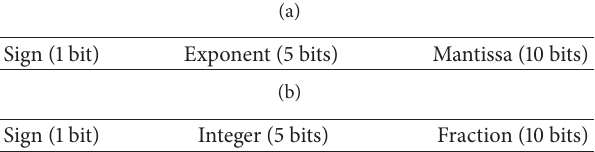
Table 1: (a) FLP-16—half precision floating point formation (FLP-